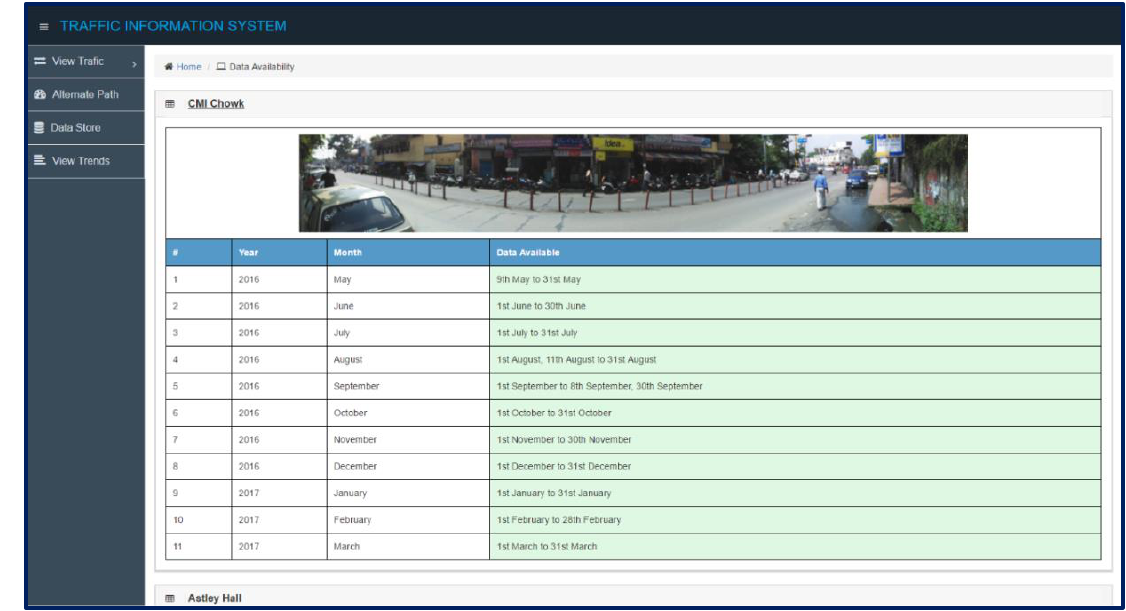
Figure 14. Traffic Data Storage in RTIS